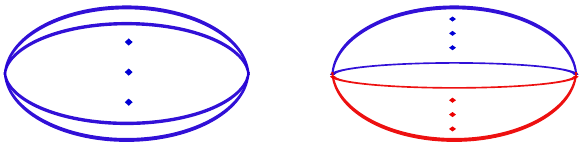
Figure 3 . Left: Simplest leading contributions to free energy from (2.1). Right: Simplest leading contributions to the free energy from